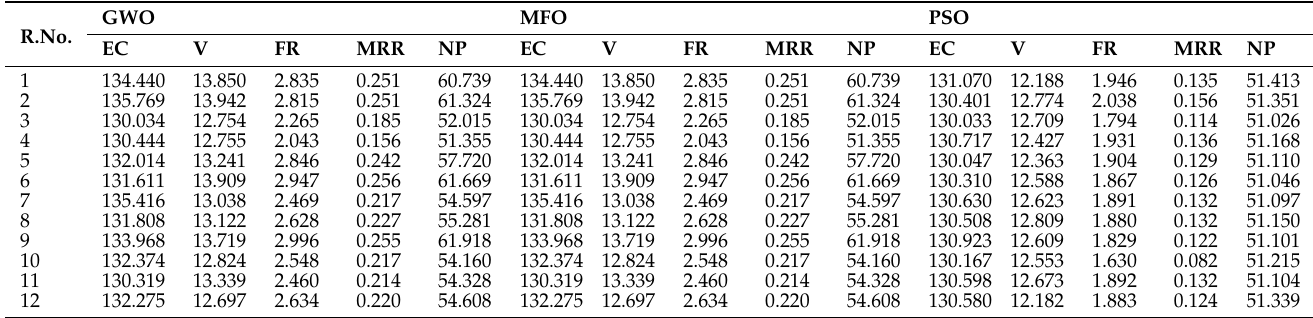
Table 14. The Pareto optimal solutions and their responses for various